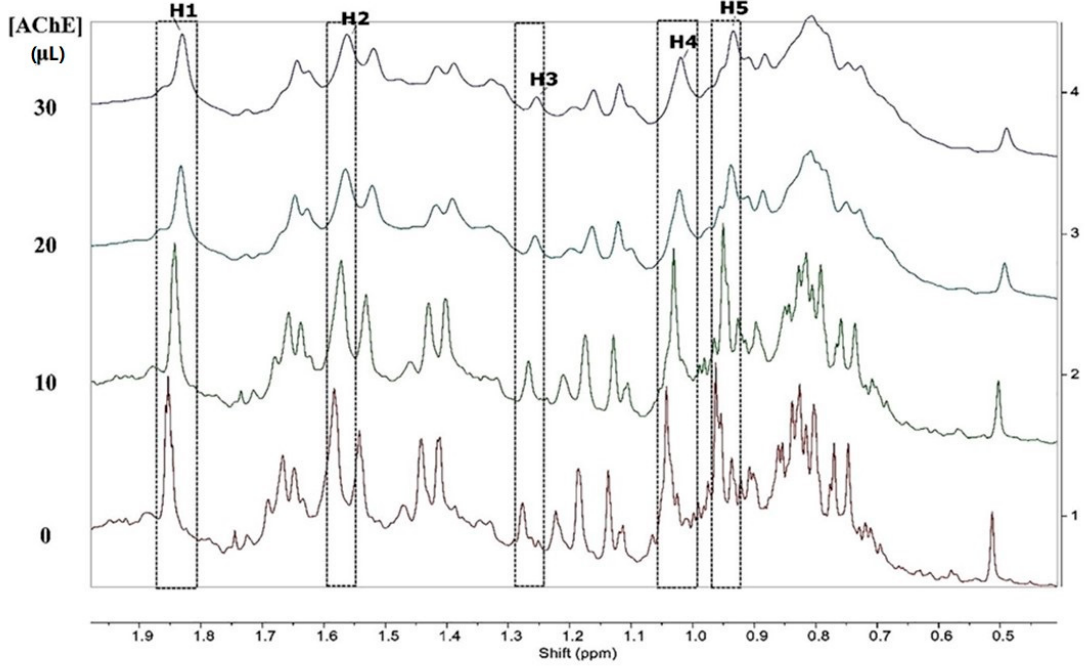
Figure 8. 1H RMN titration of essential oil of S. guianensis with AChE (0.67 mg/mL) in DMSO d6. Titrations were performed with AChE of 0 (red line), 10 (green line), 20 (blue line) and 30 uL (purple line) [49].